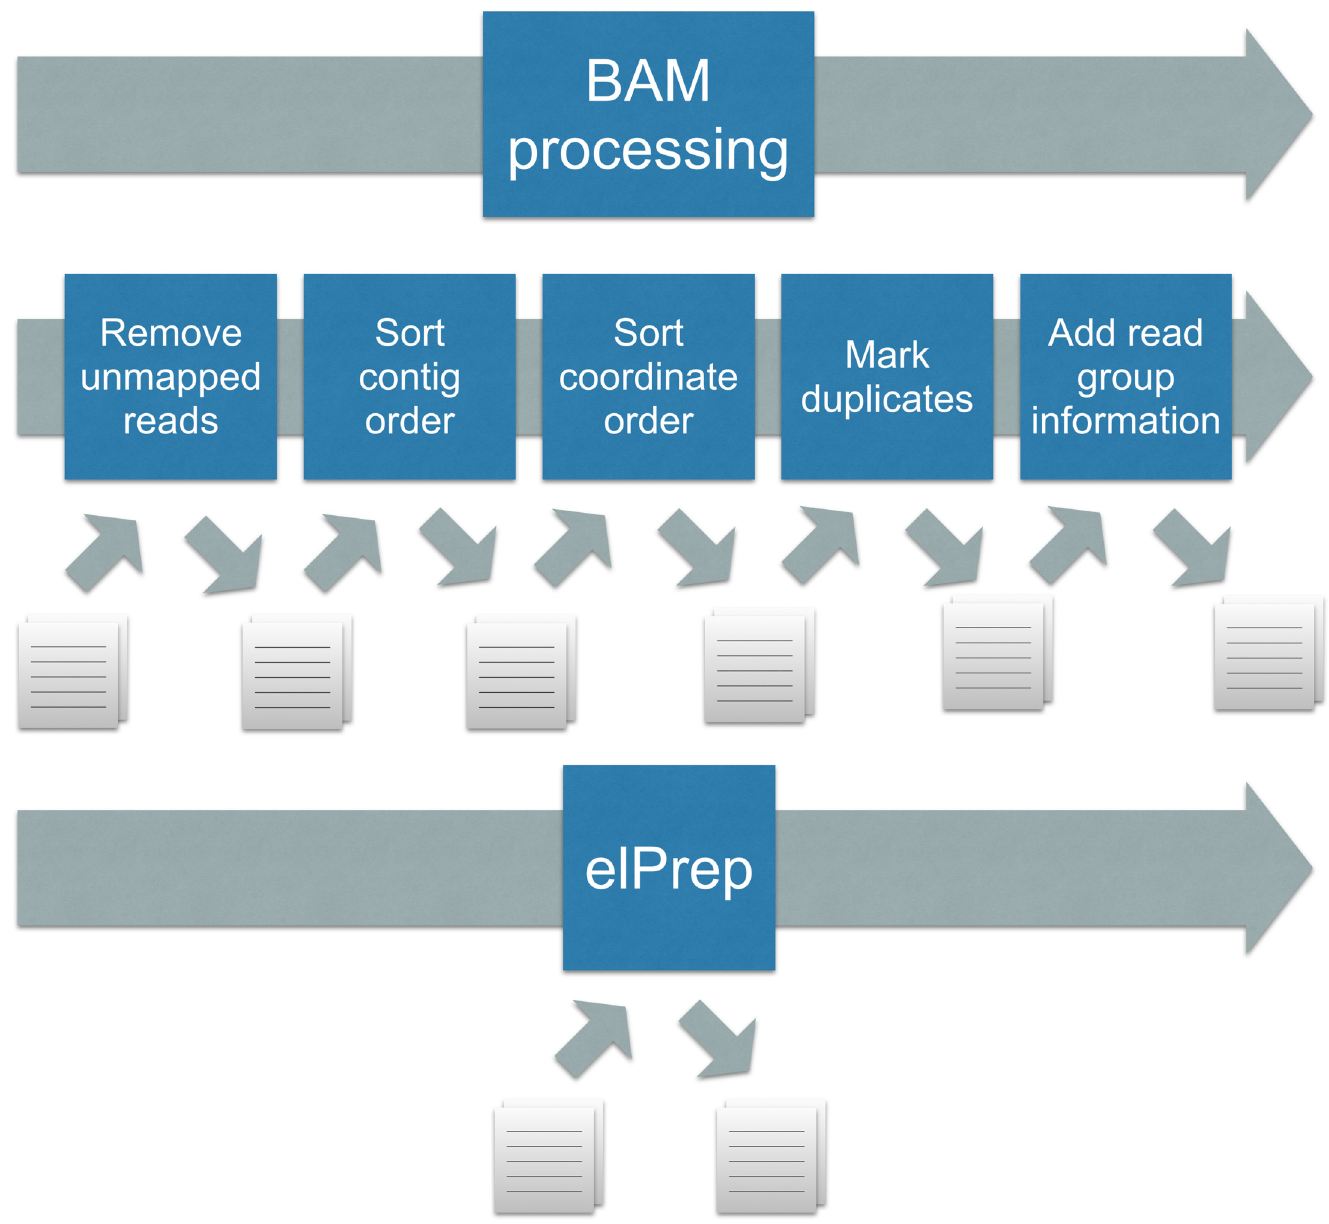
Fig 2. BAM processing: standard practice (top) versus elPrep (bottom). The standard practice is calling a (different) preparation tool for each step, which leads to repeated file I/O, as well as repeated traversal of the same SAM file. To use elPrep, one instead issues a single command that lists the preparation steps to be applied to a SAM file. elPrep internally combines the execution of the different preparation steps, resulting in a single pass over the SAM file, and avoiding repetitive file